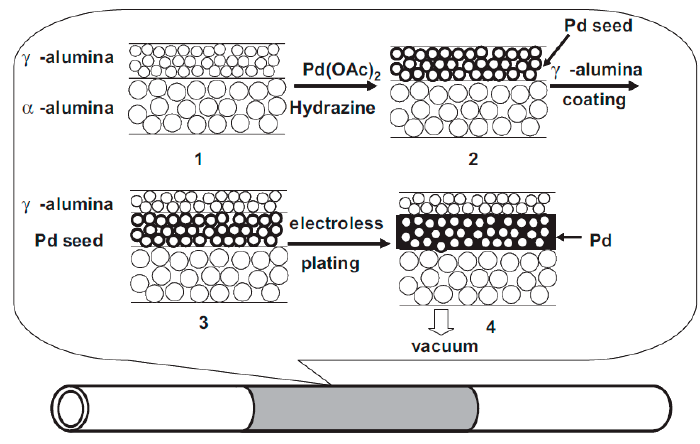
Figure 13. Schematic representation of pore-filled type membranes performed by Pacheco Tanaka et al. Reprinted from [111] with permission from Wiley VCH. Reprinted from [111] with permission from Wiley